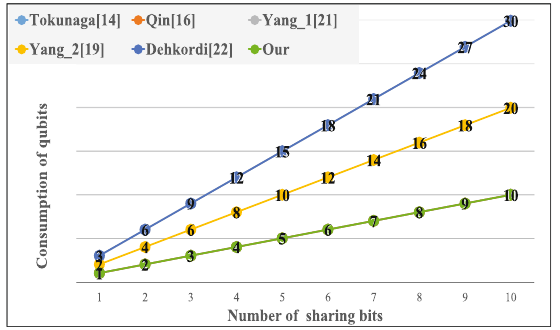
Figure 6. Comparison of the consumption of qubits for the same number of sharing bits.